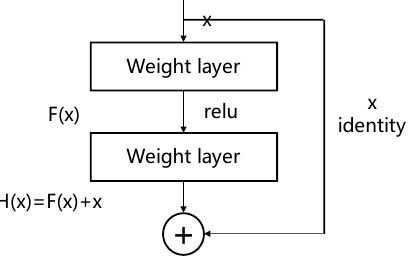
Figure 9. Learning process of the residual block.